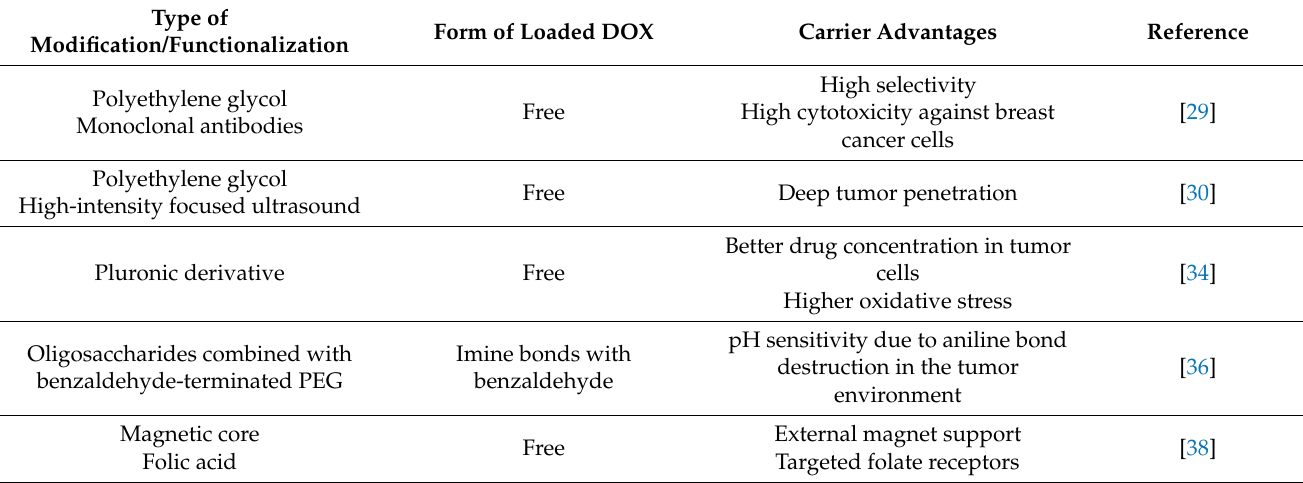
Table 2. Examples of CS-based nanoparticles for effective targeted delivery of